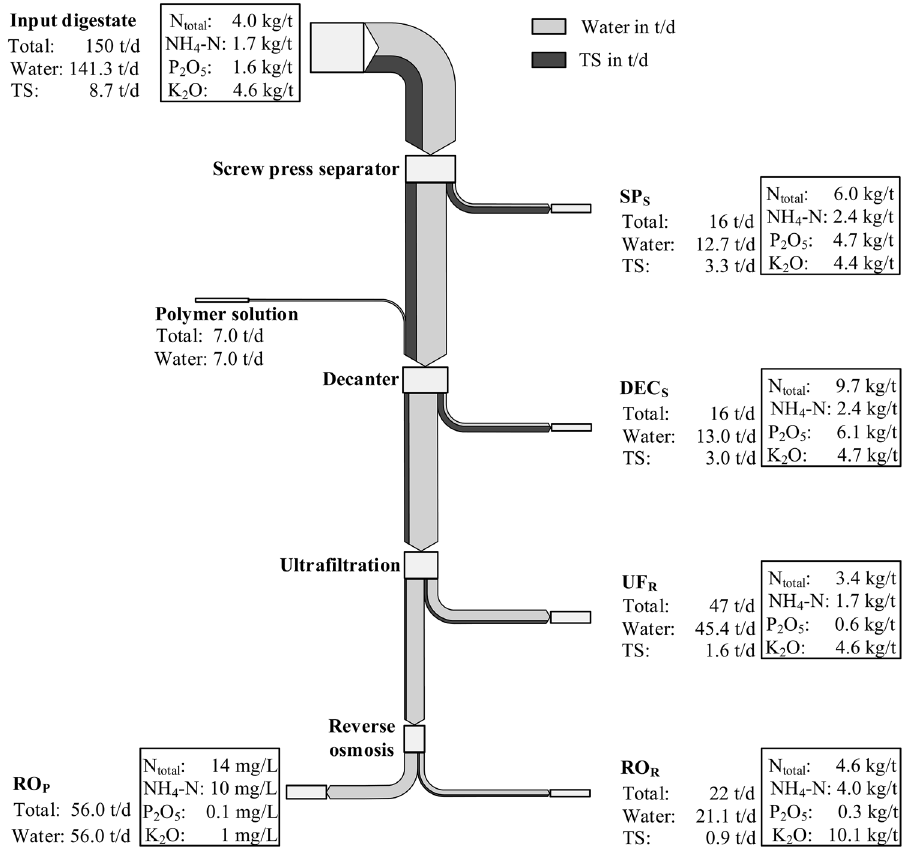
Fig. 5 Sankey diagram of total mass, solids, and water flows, extrapolated to a digestate input mass flow of 150 t day